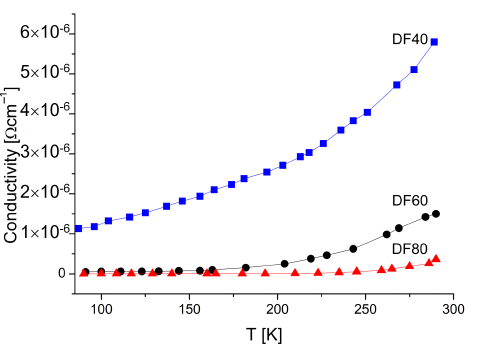
Figure 5. The temperature dependence of the conductivity in temperature range of 90–300 K.